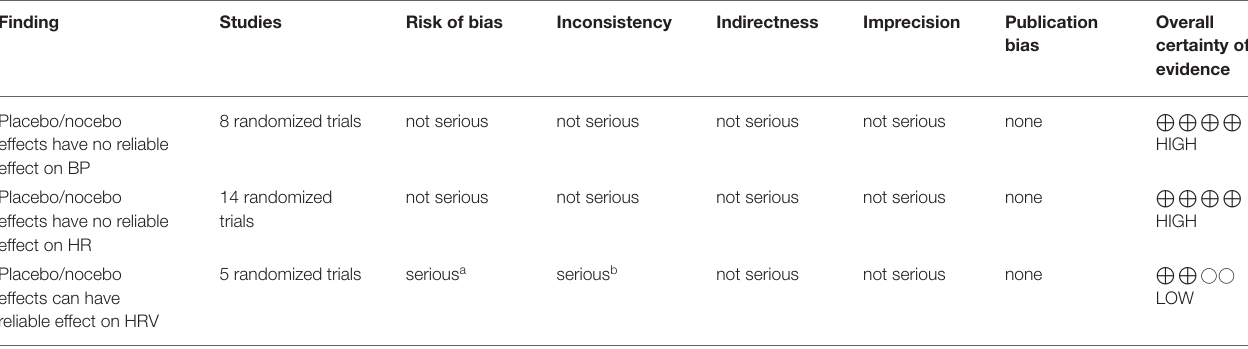
TABLE 4 | Grading the certainty of findings.